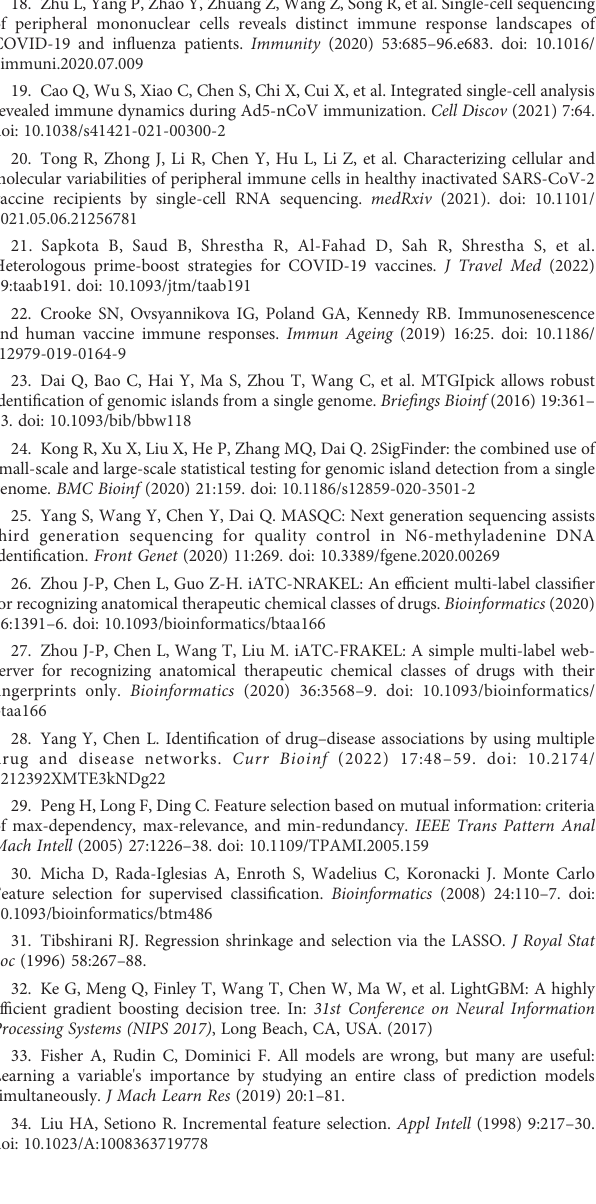
immune cell types. Each rule is composed of gene symbol and its expression level and describes how the expression level determines the class labels of